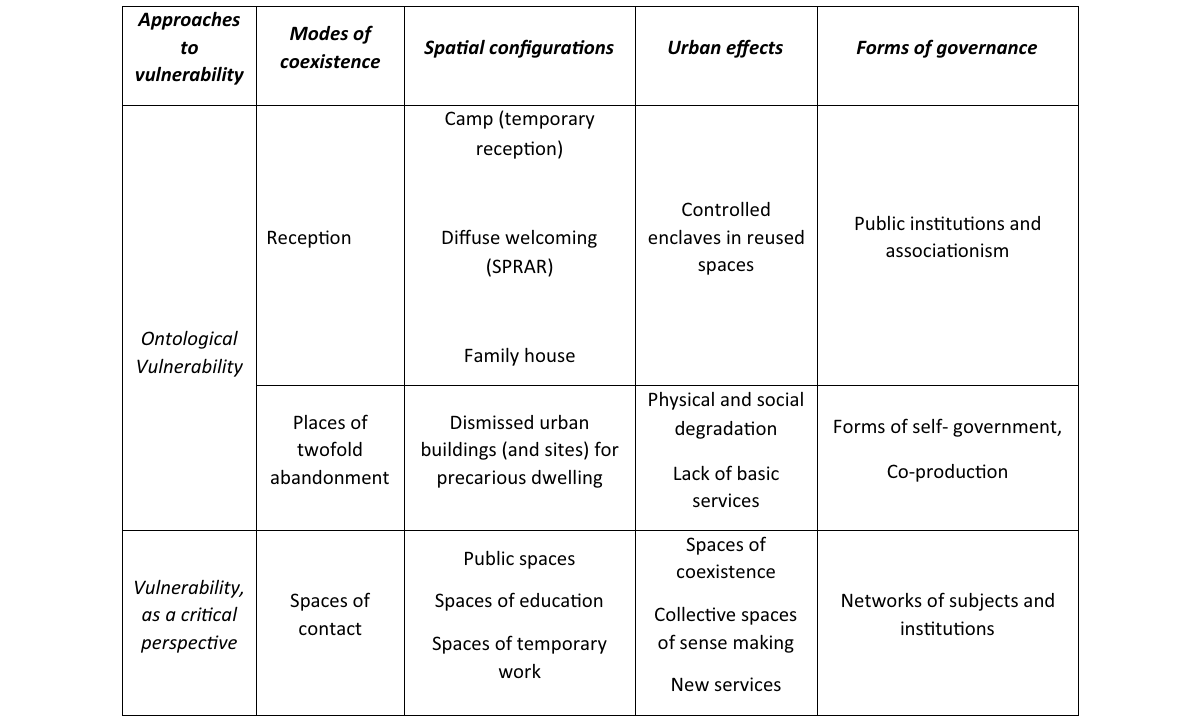
Fig. 2 Ontological and critical vulnerability: spatial and governance